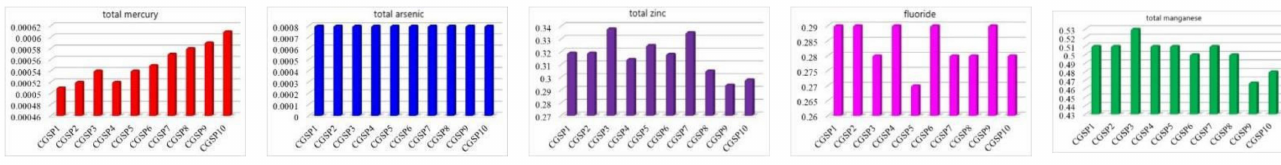
Figure 7. Test results of CCGS